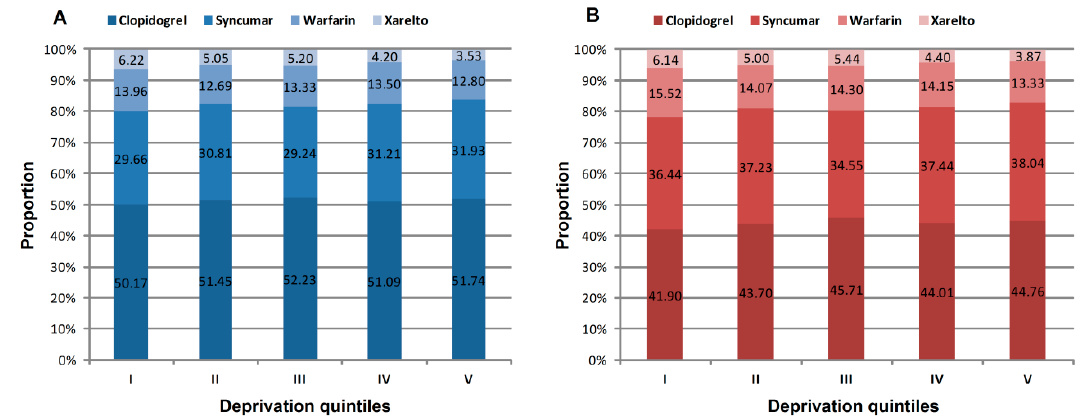
Figure 4. Antithrombotic drug prescription ( A ) and redemption ( B ) by deprivation index (DI) quintile and drug types, Hungary, 2016.